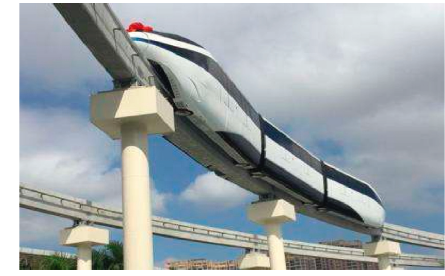
Figure 4: The cloud rail [25].